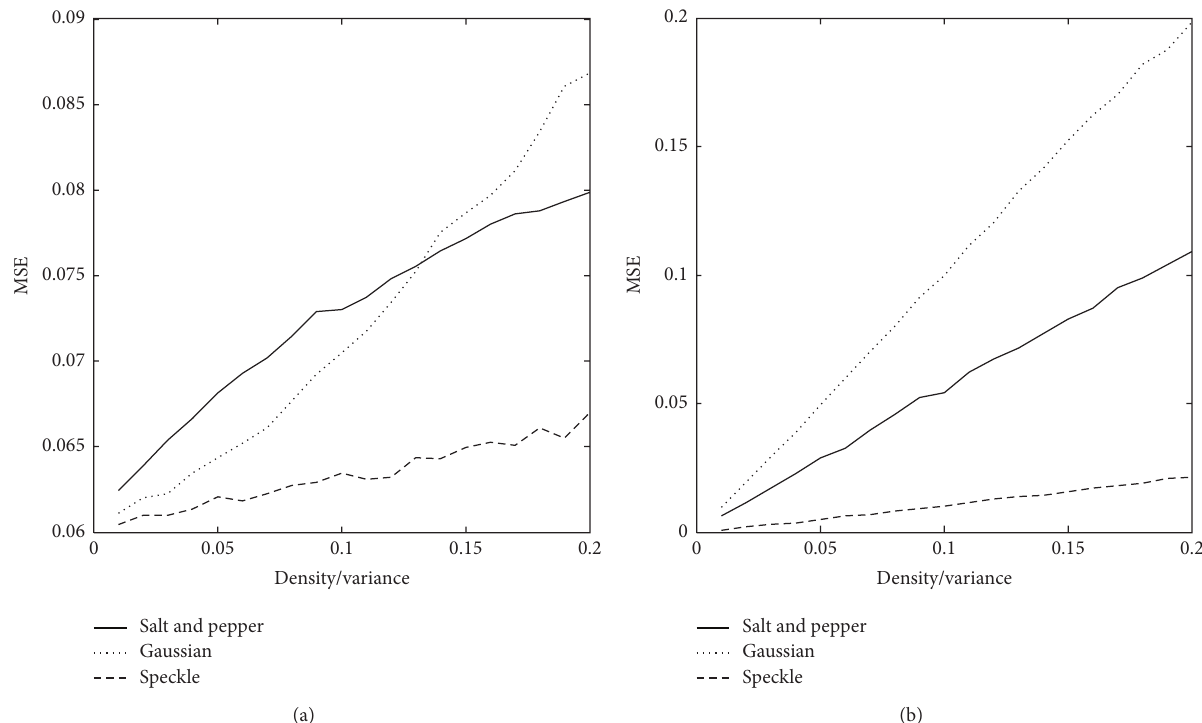
Figure 12: MSE plots for three types of noise against density/variance for (a) grayscale image Lena and (b) binary image